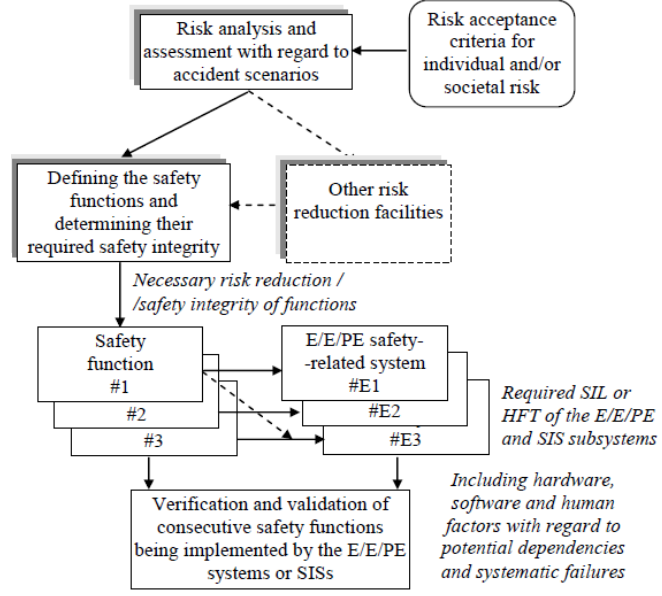
Figure 1. Allocation of requirements to the safety-related systems. Table 1. SIL probabilistic criteria.